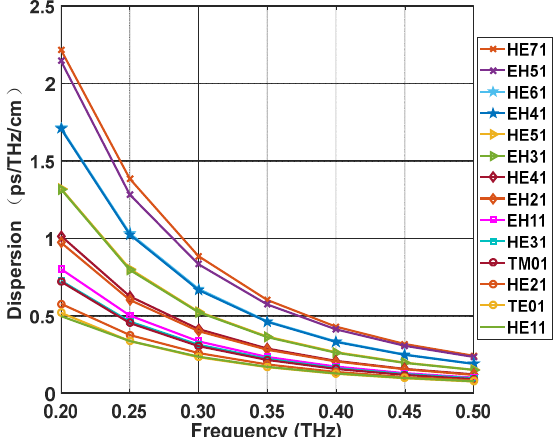
11 of 16 Figure 8. ( a ) The effective refractive index as a function of the frequency for different vector modes. ( b ) The effective refractive index difference as a function of the frequency for EH and HE modes. The dispersion of the optical fiber could cause the transmission signal to broaden, which degrades the communication quality. Excessive dispersion would result in the decrease in communication capacity and the limitation of communication distance. In the process of optical fiber design, the dispersion characteristic should be flat to reduce its influence on the mode transmission quality in the optical fiber. According to the ref- erences [21,22], the value of dispersion can be calculated as: 